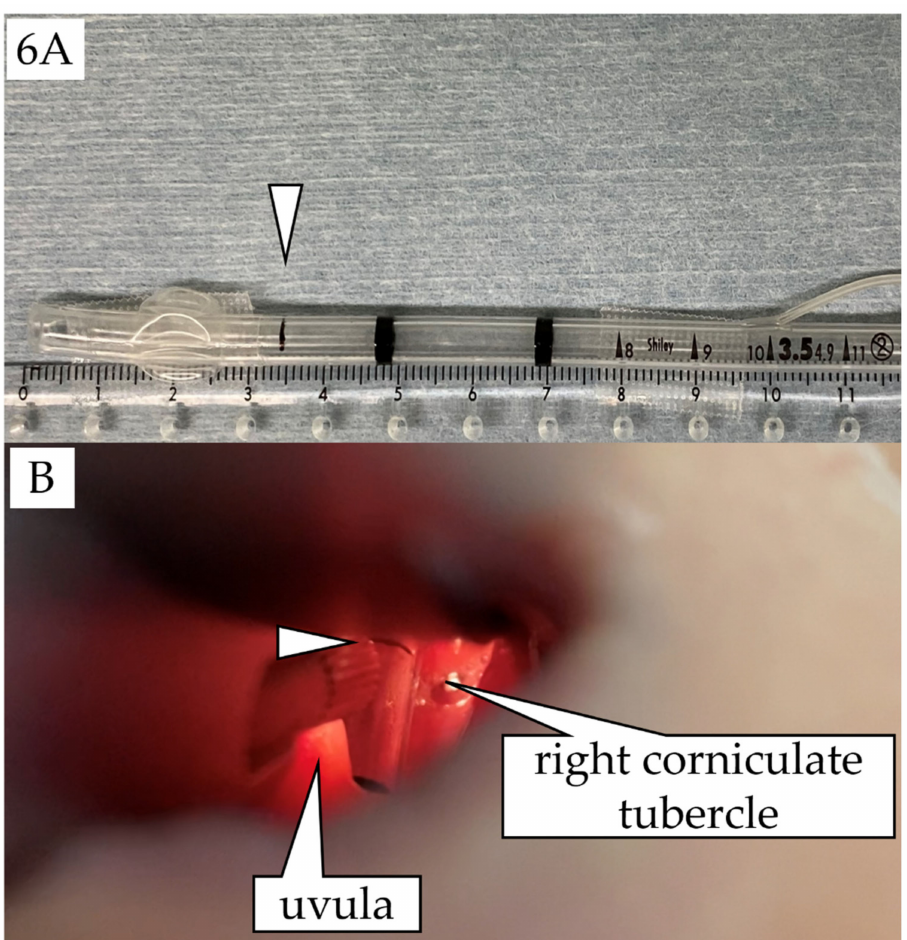
Figure 6. ( A ) An appropriate vocal cord marker ( (cid:52) ) placed at 3.5 cm (7% of body height) from the tip on a cuffed Shiley TM endotracheal tube (Covidien Japan Inc., Tokyo, Japan) with an inner diameter of 3.5 mm before the endotracheal intubation procedure in a Japanese newborn baby with a body height of 51 cm; the same patient as Figure 1. ( B ) Laryngoscopy using a Macintosh curved-blade laryngoscope (size 0). The ETT was intubated with a depth such that the appropriate vocal cord marker ( (cid:52) ) is located at the vocal cord